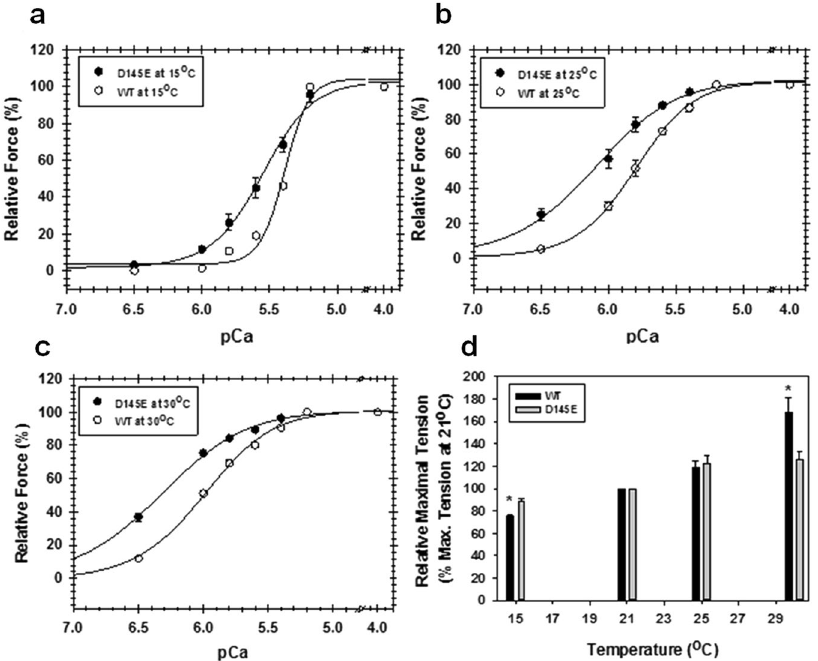
Figure 7. Temperature dependence for Ca 2 + sensitivity and maximum force of cardiac skinned fibres is more pronounced following reconstitution with D145E cTnC. The Ca 2 + sensitivity (pCa 8.0 to 4.0) of isometric force was measured at ( a ) 15° ( b ) 25° and ( c ) 30 °C in fibres depleted of native cTnC and reconstituted with HcTnC WT ( ○ ) or D145E ( ● ). Ca 2 + sensitivity was measured at all three temperatures on each fibre. Each curve is normalised to its own maximum (at pCa 4.0). ( d ) In a different set, each fibre was reconstituted with one isoform and maximal tension was measured at 21 °C and at one other temperature ( see Methods ). Data are normalised to the value at 21 °C. * p < 0.05 compared to WT at the same temperature. In ( a–d ), values shown are means ± s.e.m. (n = 4–5). In some cases error bars fall within the